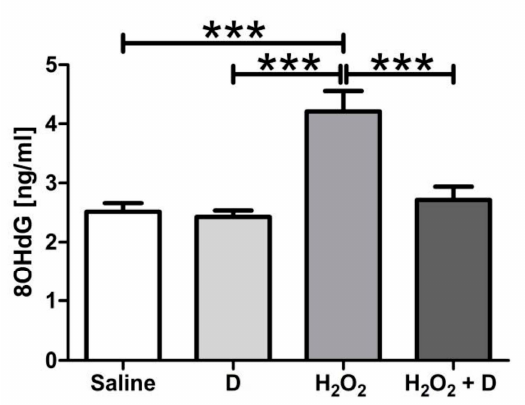
Figure 6. Graph showing 8-OHdG results for ARPE-19 cells measured by ELISA. VITD was able to significantly reduce the 8-OHdG levels elevated by H 2 O 2 (*** p < 0.001). n = 3.